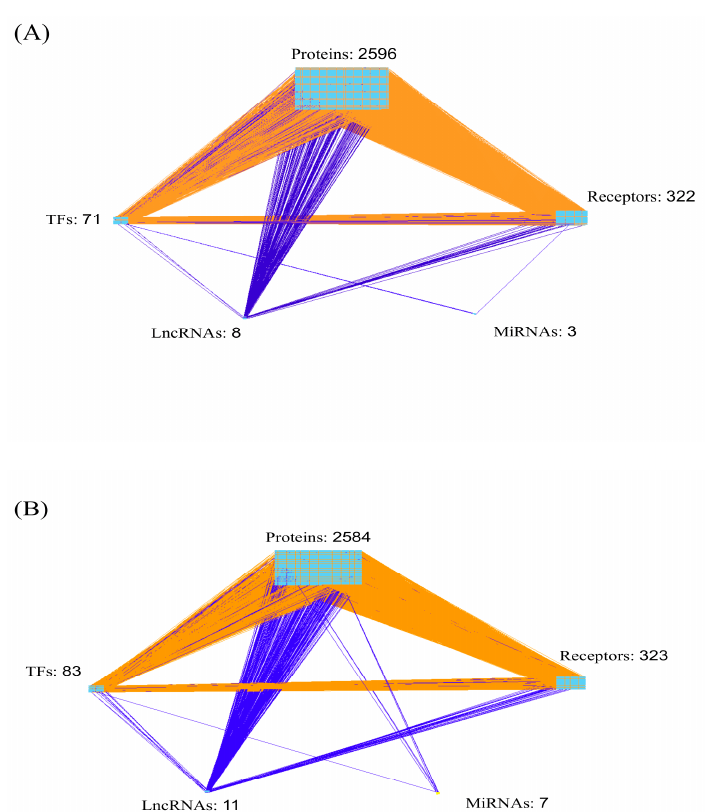
Figure A2. ( A ) The core GWGEN network of non-T2D; ( B ) The core GWGEN network of T2D. The core GWGENs were extracted by PNP method the real GWGEN to simplify the pathogenic analysis of T2D. The numbers in the figure signify the node numbers of proteins, TFs, Receptors, LncRNAs and MiRNAs. The orange lines indicate the protein–protein interactions and the blue lines denote the gene regulations.